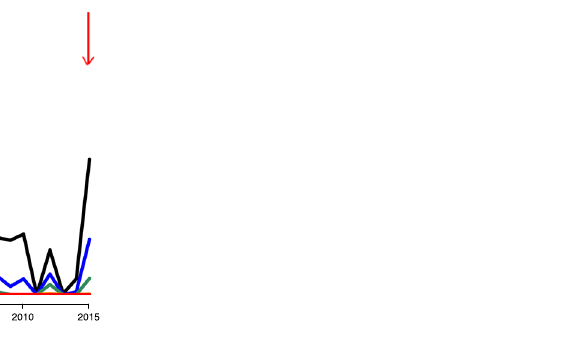
6 SCiEnTifiC REPORtS | 7: 8144 | DOI:10.1038/s41598-017-08146-z